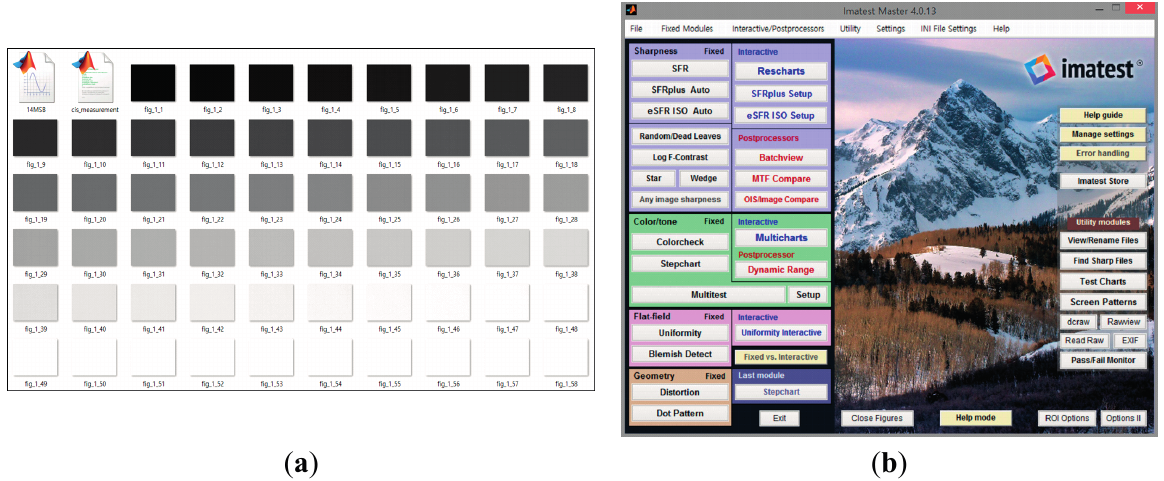
Figure 12. Measured environments for noise performance: ( a ) captured image dependent on the variation of light intensity ( b ) software program IMATEST ® for noise analysis.